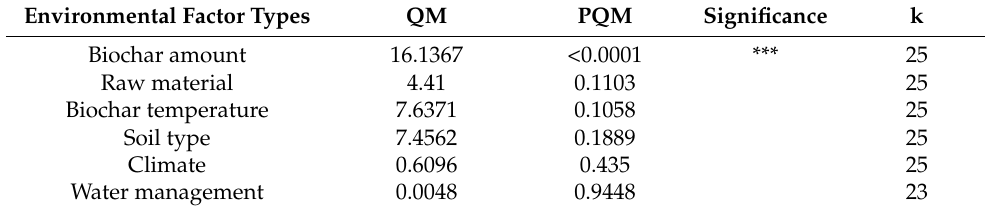
Table 2. Factors affecting heterogeneity of soil TC in paddy soils amended with biochar.